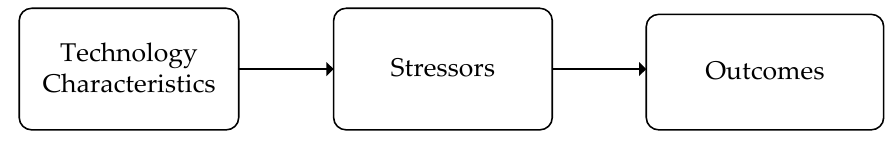
Figure 1. Stressor-stress-outcome (SSO) framework.